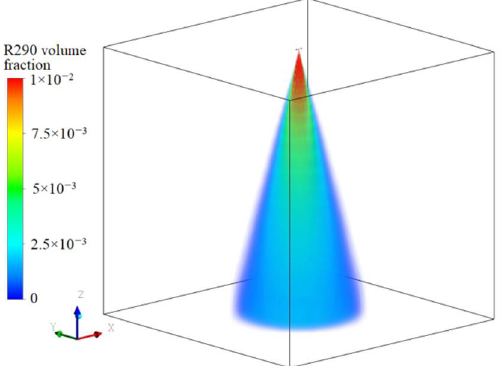
Figure 10. Flow field distribution of the leaked R290 gas in external space.